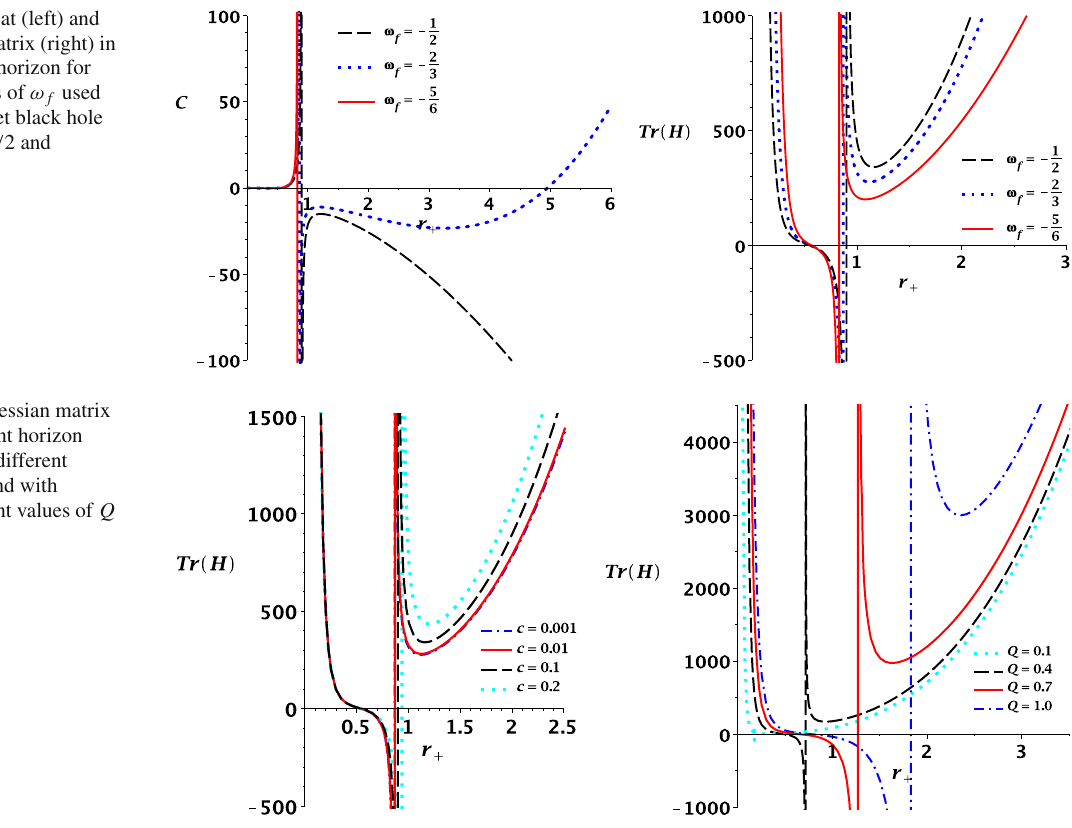
Fig. 4 Trace of Hessian matrix in terms of the event horizon with Q = 1 / 2 for different values of c (left) and with c = 0 . 1 for different values of Q